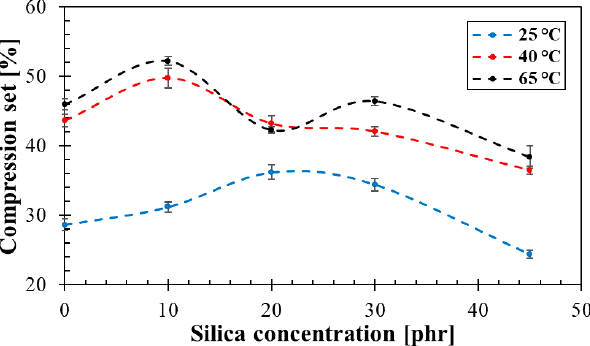
Figure 5. Effect of silica concentration on compression set of the investigated rubber composites under different compression temperatures.